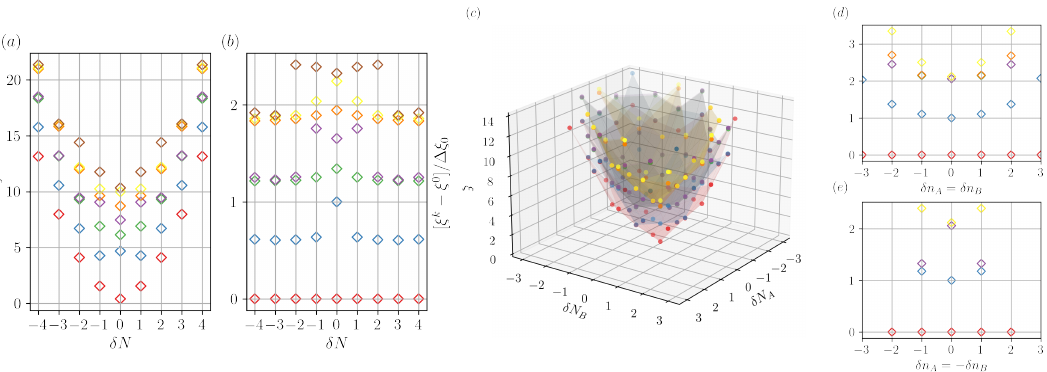
Figure 3: Entanglement spectrum for the same systems as in Fig. 2 but in the Mott insulator phase at U / J = 4 ( ( a ) and ( b ) ) and in the PSF phase at U ( ( c ) , ( d ) and ( e ) ). In ( a ) , ( b ) and ( e ) the behaviour of the ES is clearly no more